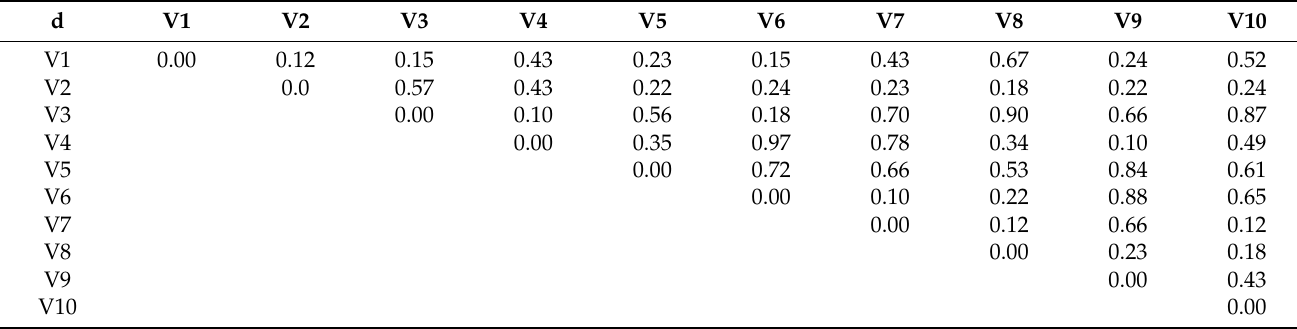
Table 8. Correlation degree of 10 variables.